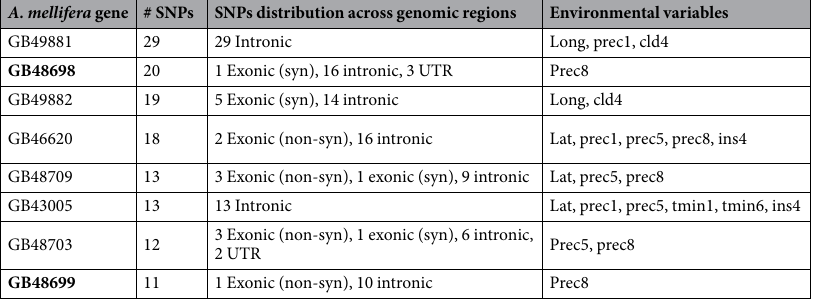
Table 2. Candidate genes containing more than 10 SNPs detected concurrently by at least two selection methods. Genes marked in bold carry SNPs that were cross-detected by iHS and/or PCAdapt. The correlated environmental variables are longitude (long); latitude (lat); cloud cover in April (cld4); insolation in April (ins4); precipitation in January (prec1), May (prec5) and August (prec8); minimum temperature in January (tmin1) and